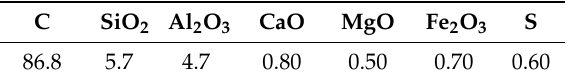
Table 5. The Coke chemical composition, in wt.